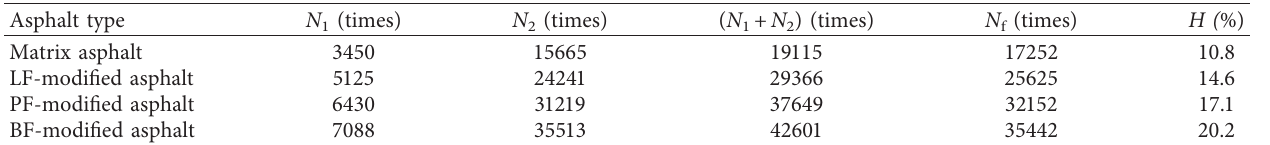
Table 10: Results of the self-healing property of asphalt